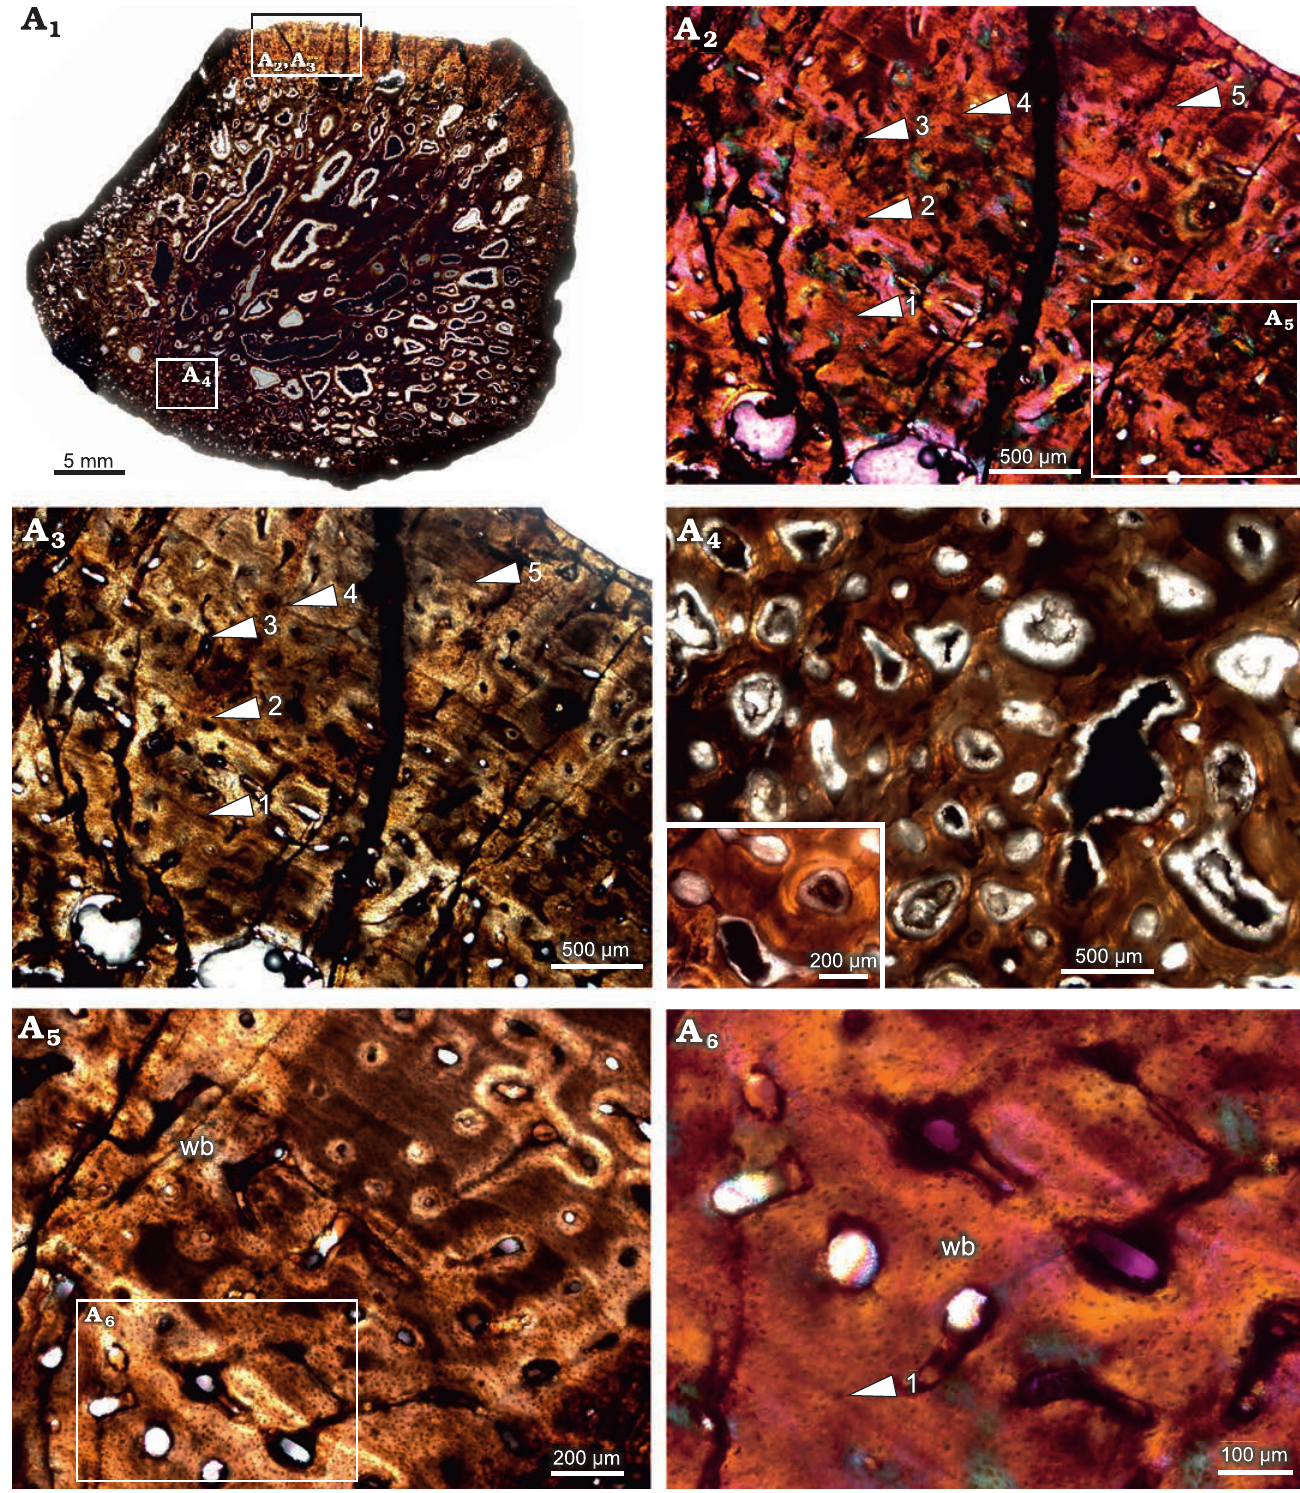
Fig. 5. Transverse section of the rib (BP/1/5409) of cf. Jonkeria sp. from the middle Permian Tapinocephalus Assemblage Zone of the Karoo Basin of South Africa. A 1 , overall view of the rib showing the highly cancellous nature of the cortex; note that only the top area of the section preserves the compact cortical bone tissue. A 2 , A 3 , detail showing slight change in the tissue type around the lines of arrested growths but overall matrix is woven; note: numbers associated with arrowheads indicate lines of arrested growth (LAGs) in ascending order from the medullary region to periosteal peri phery. A 4 , detail showing enlarged erosional cavities (inset). A 5 , detail showing fibrolamellar bone between lines of arrested growth. A 6 , detail showing dense woven matrix; note the change in the density of osteocyte lacunae around the LAG (number associated with arrowhead indicates LAG). Abbreviation: wb, woven bone. Photographs under ordinary light (A 1 , A 3 , A 4 , A 5 ), and cross-polarized light with lambda compensator (A 2 , A 6